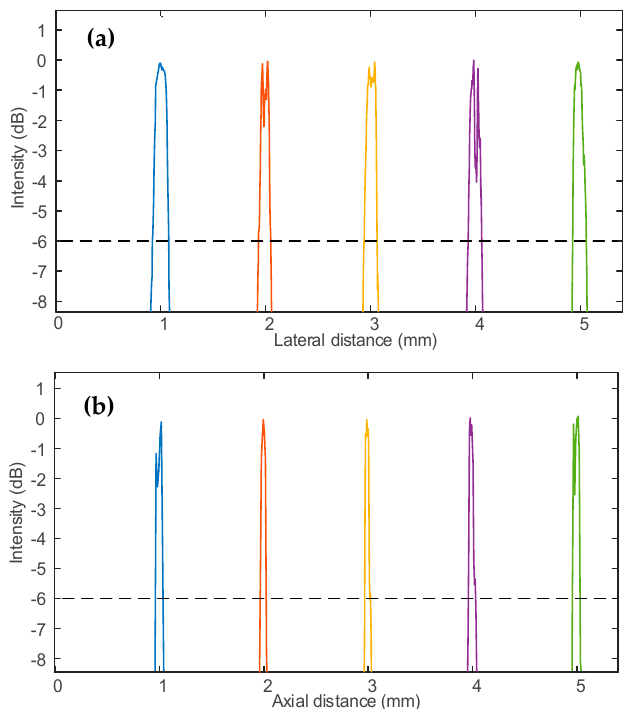
Figure 11. The measured resolution of the MFP transducer T3 with five focal points. ( a ) Lateral brightness profile. ( b ) Axial brightness profile.